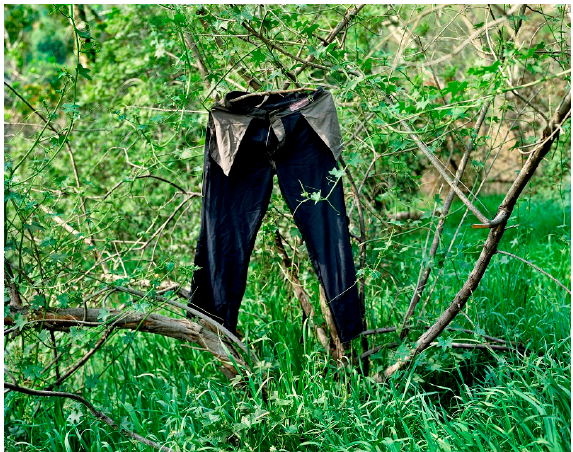
Figure 5. Anthony Hernandez, Landscapes for the Homeless #54 (1989), © Anthony Hernandez.